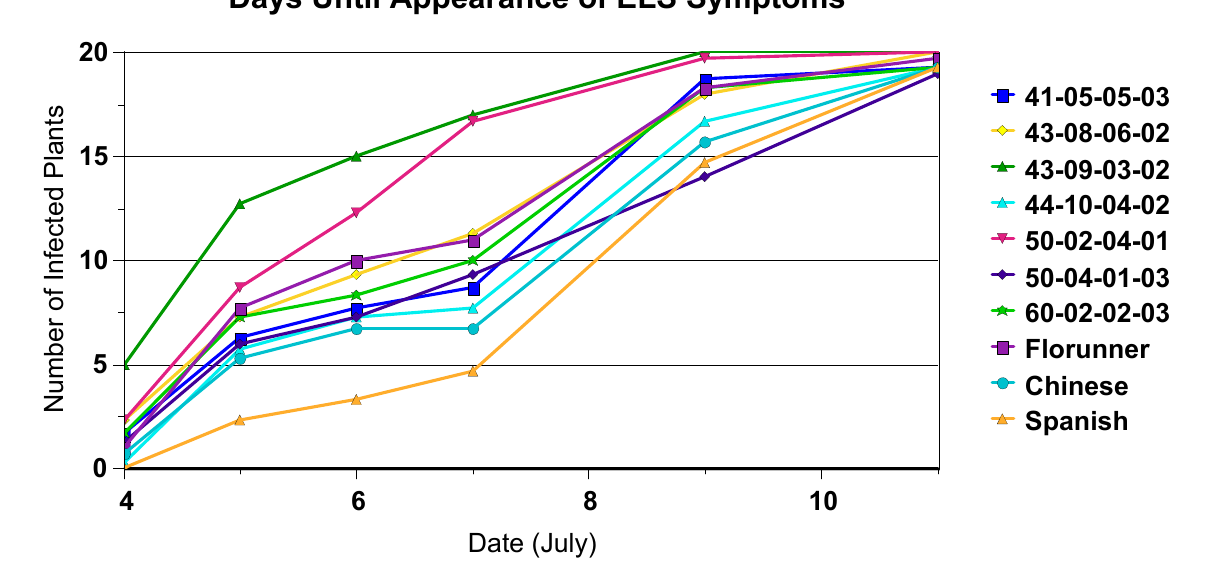
Figure 1. Days until appearance of early leaf spot symptoms, illustrating time to development of symptoms in 50% of plants at Nyankpala in 2006.